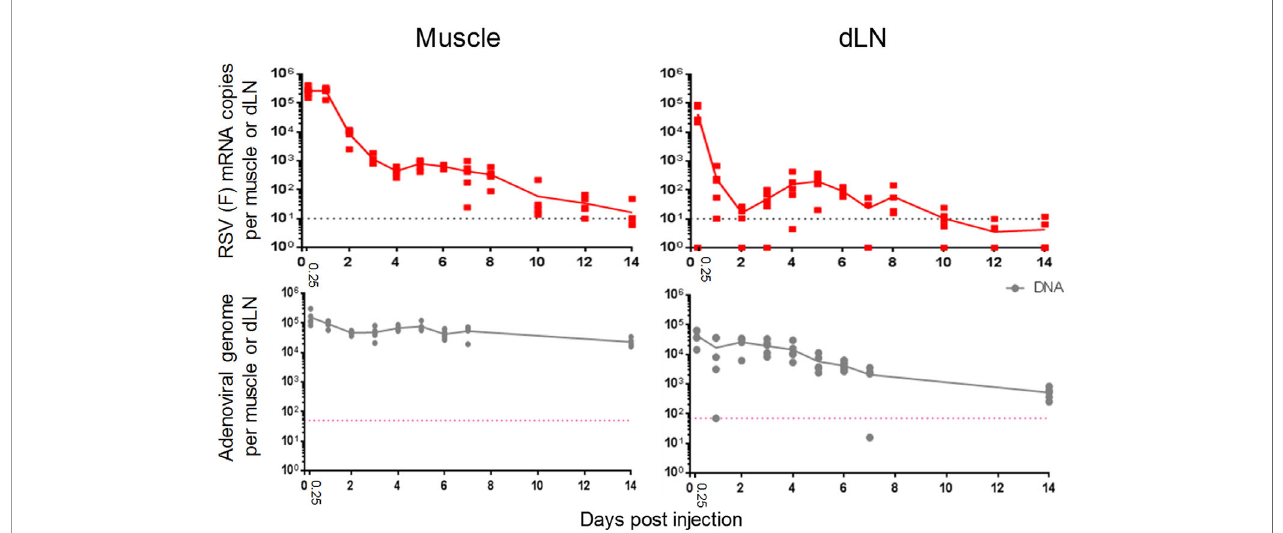
FIGURE 1 | Different kinetics of transgene mRNA expression versus viral vector DNA levels in mice. Expression levels of RSV fusion (F) mRNA and ChAd155 viral DNA levels (top and bottom panels, respectively) detected in murine muscles (left) and draining lymph nodes (dLN; right) are shown. Mice (N = 5/time point) were injected intramuscularly with ChAd155-RSV (5 × 10 8 vp) or buffer (control) at Day 0. Injections were performed either unilaterally as one full dose for mRNA quanti fi cation, or bilaterally as two half doses for DNA quanti fi cation. Depending on the time point, graphs represent data from two or three (mRNA) or one or two (DNA) independent experiments. Solid lines represent mean expression levels; symbols represent means or single values per animal. Dotted lines represent the lower limits of